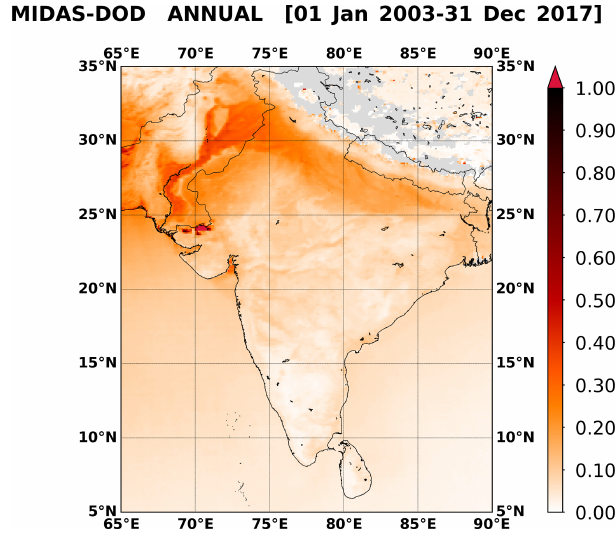
Figure 4. As in Fig. 1 but for the Indian subcontinent.